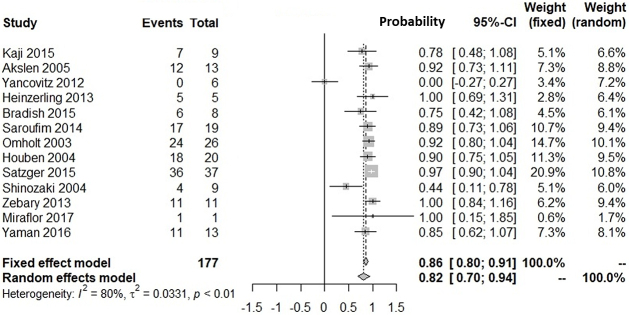
Probability of BRAFV600E (−) metastatic lesions of melanoma against BRAFV600E (−) in primary lesions in pairwise comparisons.